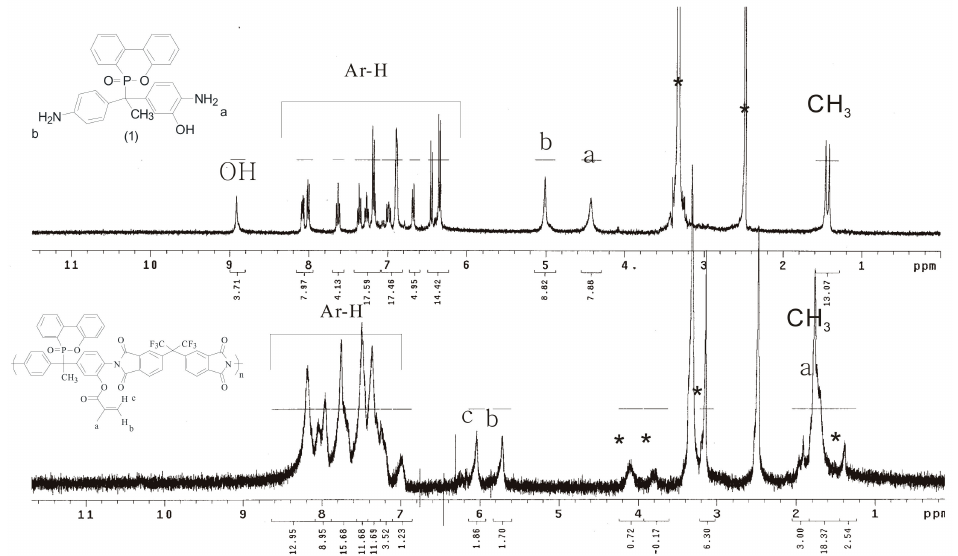
Figure 1. 1 H-NMR spectra of hydroxyl diamine (1) and P1–MMA in DMSO- d 6 . (*: